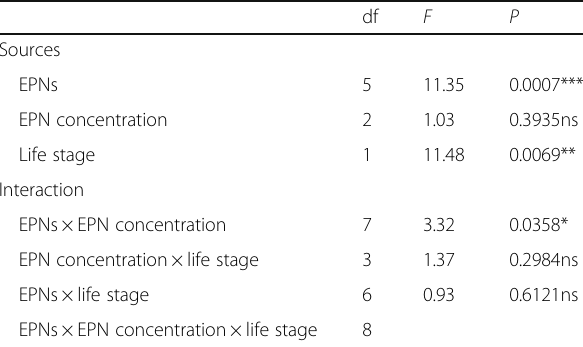
Table 3 Summary of ANOVA results for reduction % of different T. tabaci life stages caused by different treated